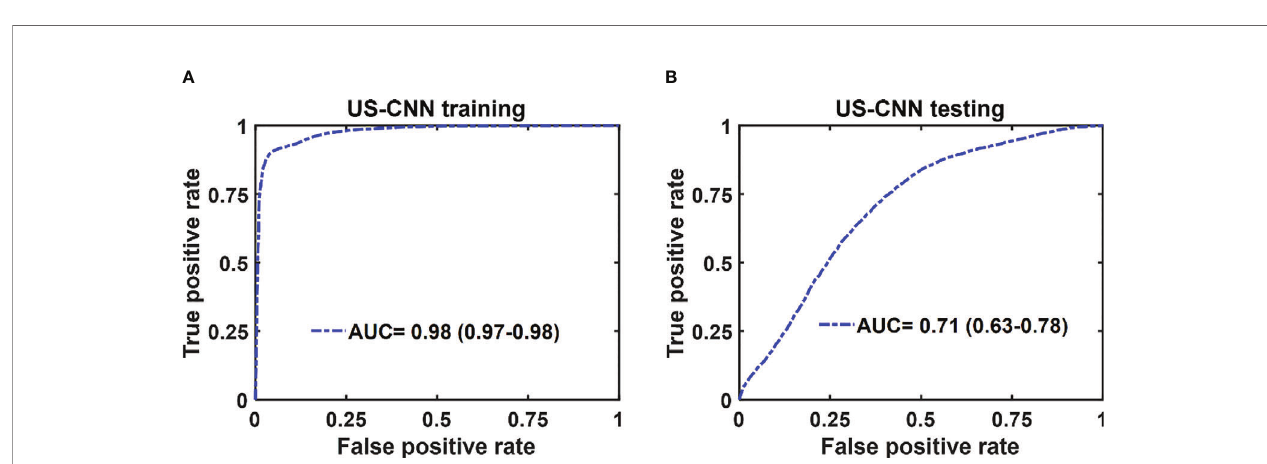
FIGURE 8 | Average ROCs of PAM-CNN model. (A) training and validation results, (B) testing results. The 95% CIs are indicated in parentheses.